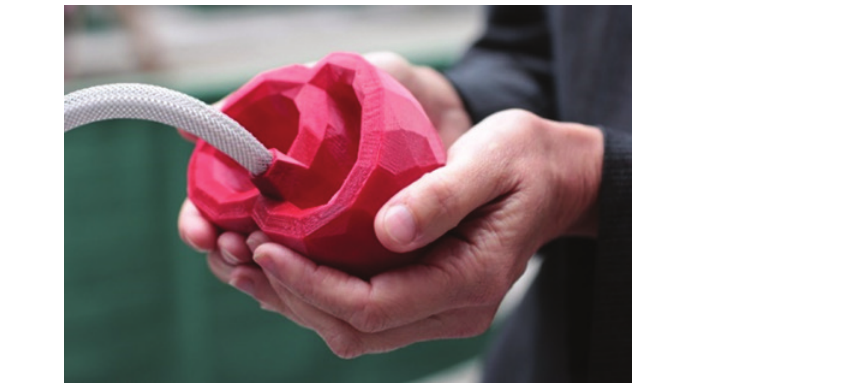
figure 2: Rusty squid and King’s college london, Heart in Your Hands ,